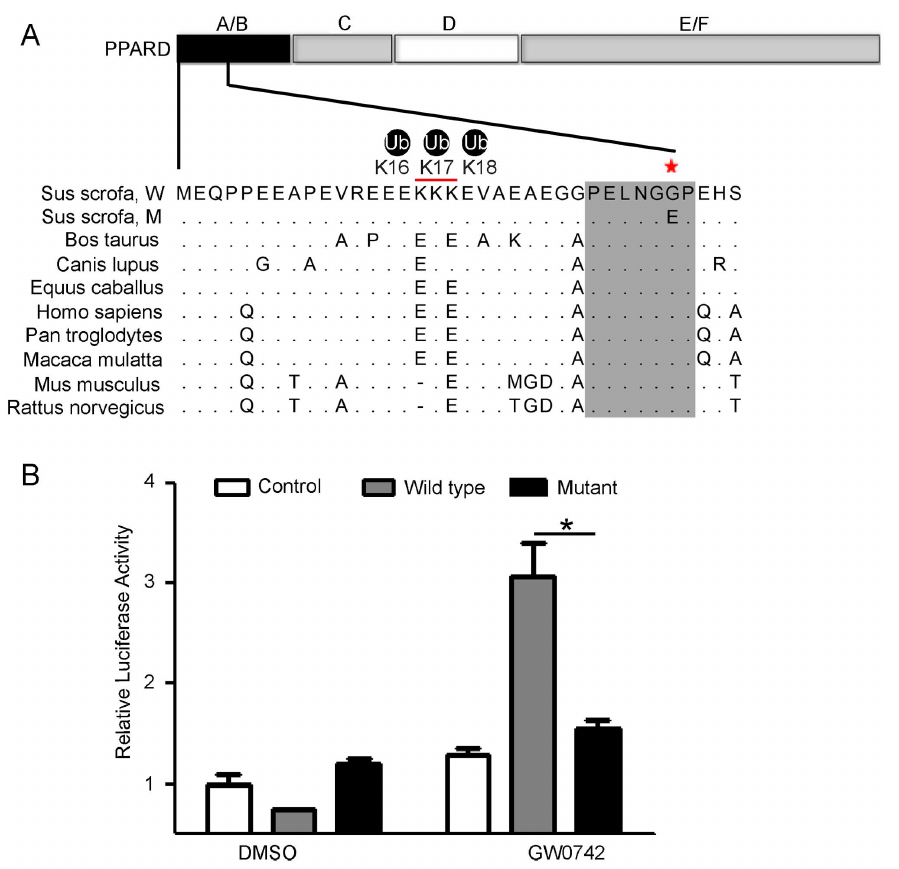
Figure 1. The G32E substitution prevents ligand-induced transcription activity of sPPARD. (A) Glycine 32 in the A/B domain of sPPARD is conserved across mammals as described in [9]. The asterisk and red line indicates the positions of glycine 32 and lysines 16–18. (B) PK-15 cells were transfected with pcDNA4A-His, wild-type sPPARD, and G32E mutant expression vectors along with PPREx3-tk-Luc and pCX-nLacZ reporter vectors. Cells were incubated overnight with DMSO or GW0742 (5 m mol/L). The ratio of firefly luciferase to b -galactosidase activity was defined as relative luciferase activity. Data represent -fold increase (mean 6 S.D. of triplicate experiments) relative to empty vector-transfected and ligand untreated cells. * P , 0.05 indicates significant difference between wild-type and G32E mutant sPPARD in the presence of ligand.